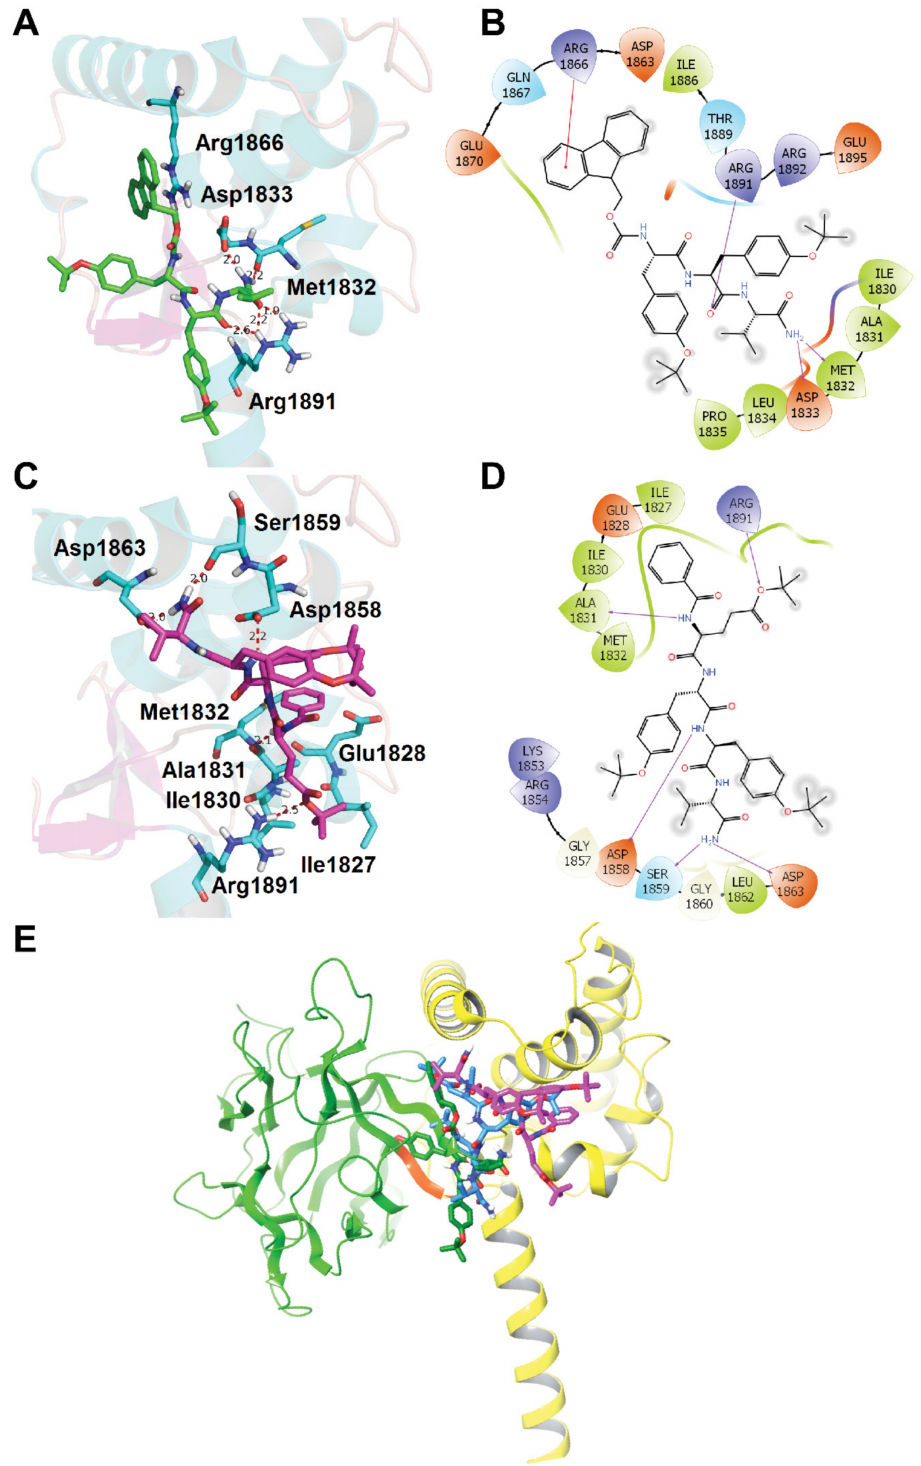
Figure 6. Molecular docking studies of compounds 12 and 19 . The Nav1.6 C -terminal tail